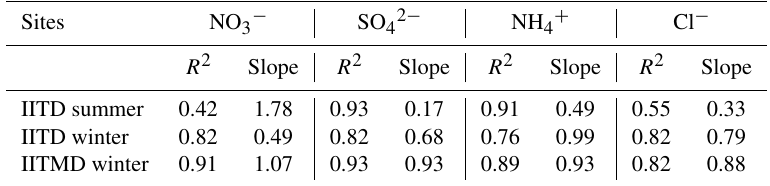
Table 2. Regression coefficients and slopes for the comparison of WSIs measured by the HR-ToF-AMS and IC. Sites NO 3 − SO 42 − NH 4 + Cl − R 2 Slope R 2 Slope R 2 Slope R 2 Slope IITD